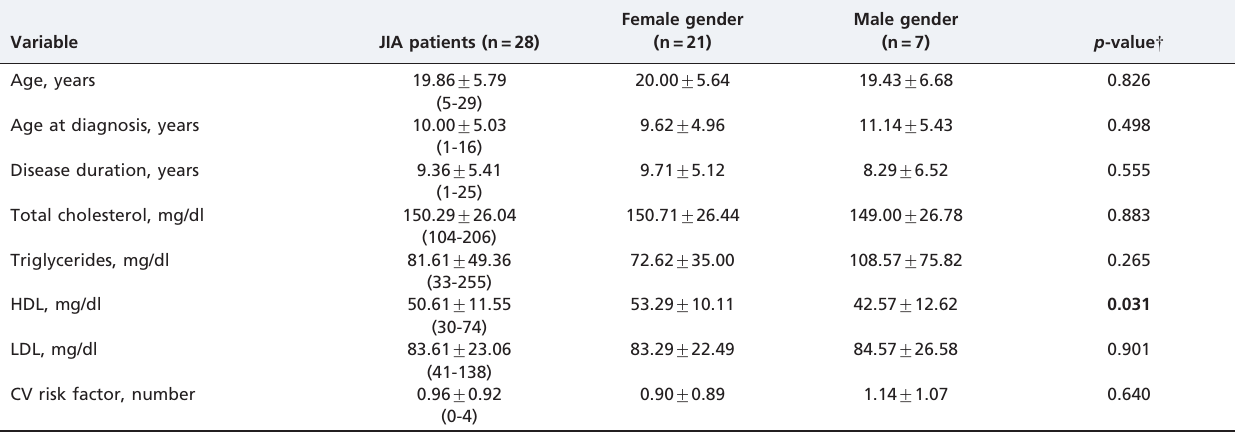
Table 1 - Characteristics and lipid profiles of 28 patients with polyarticular